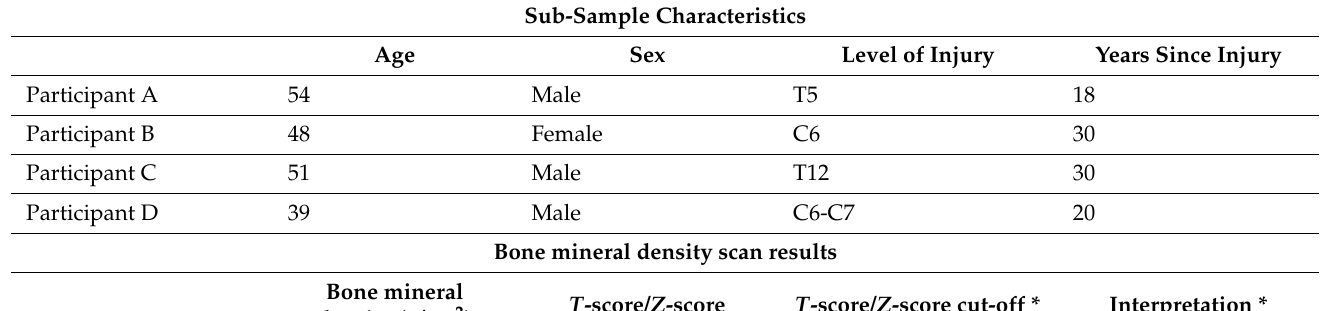
Table 2. Bone mineral density of a sub-sample ( n = 4).